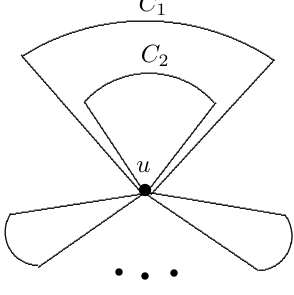
Figure 7: The planar embedding H of D ( S ) .